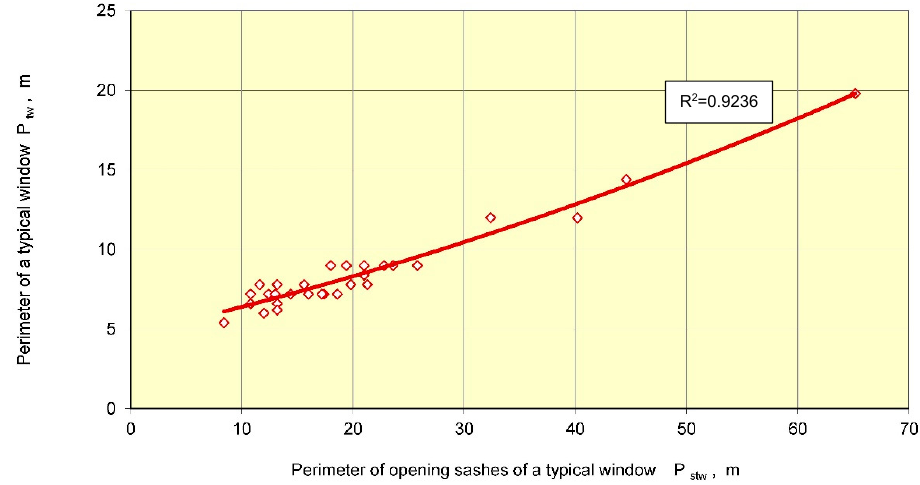
Figure 6. Relations between the perimeter of a typical window P tw and perimeter of opening sashes of a typical window P stw in education buildings.